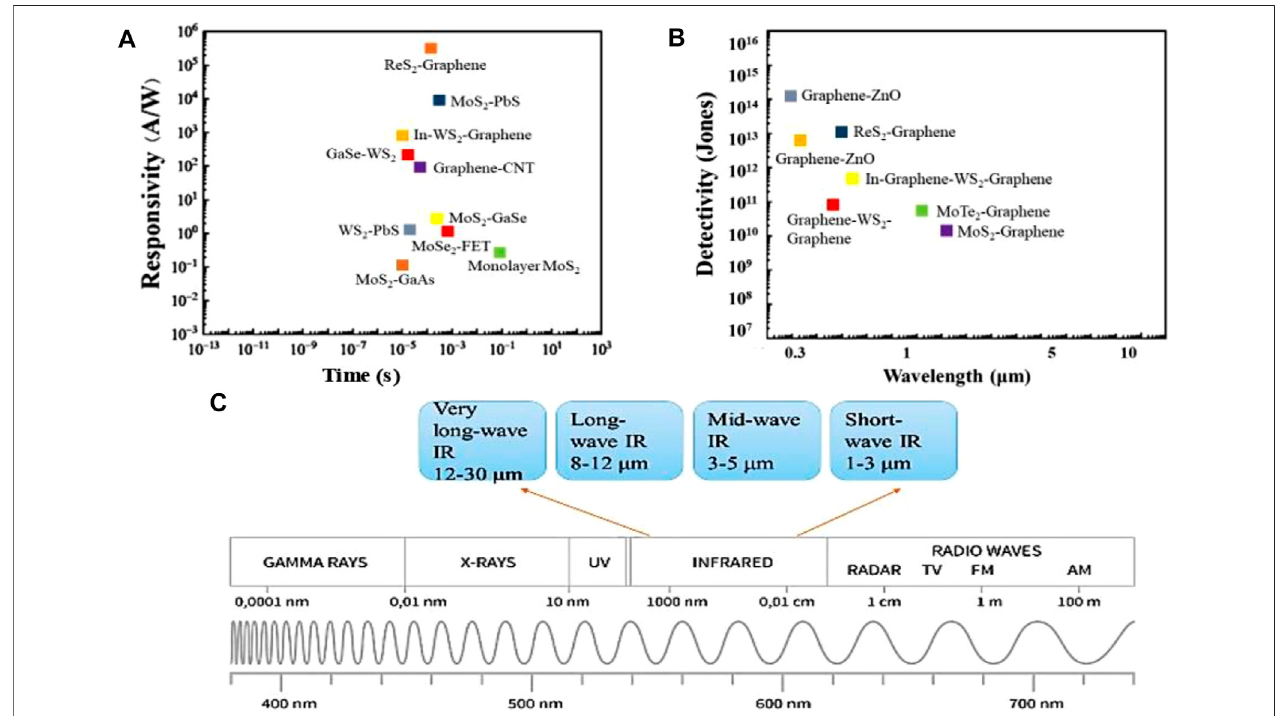
FIGURE1| Performancecomparisonofvarious2Dmaterials-basedphotodetectors, (A) Photoresponsivityofconventionalmaterialsandtheirheterostructuresfor IR photodetection, (B) Detectivity of 2D materials and their heterostructures for IR photodetection, and (C) Electromagnetic spectrum along with targeted ranges as summarized in this